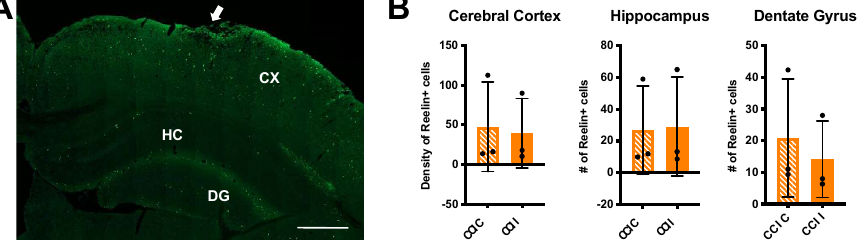
Figure 4. No change in the number of Reelin + cells 72 h post-CCI. ( A ) Representative image of a CCI ipsilateral brain section immunolabeled with Alexa Fluor 488-conjugated Reelin monoclonal antibodies 72 h after injury. The arrow indicates the site of injury. CX = cerebral cortex; HC = hippocampus; DG = dentate gyrus. Scale bar: 500 µ m. ( B ) Quantification of Reelin + cells from n = 3 CCI mice. Each value is the average of three di ff erent sections / brain. Data in the cerebral cortex represent the average density of Reelin + cells (number of cells / six ROIs), whereas data in the hippocampus and dentate gyrus represent the total number of cells counted in the entire structure. Statistical analysis was conducted comparing contralateral (C) to ipsilateral (I) values using Wilcoxon matched-pair tests (cerebral cortex) or paired t -tests (hippocampus and dentate gyrus). The number of Reelin + cells was una ff ected by CCI. Scatter dot plots show individual data points and the mean values +/- SD.